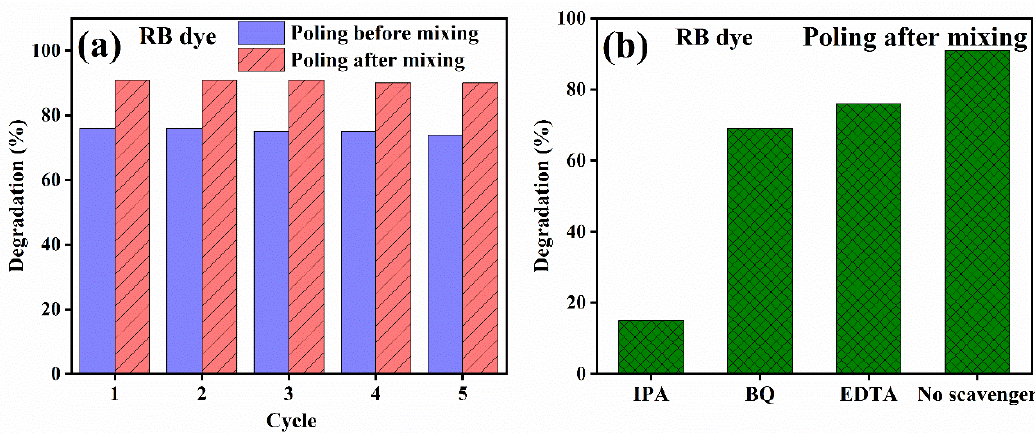
Figure 5. ( a ) Re-usability and ( b ) scavenger test during piezocatalytic activities.